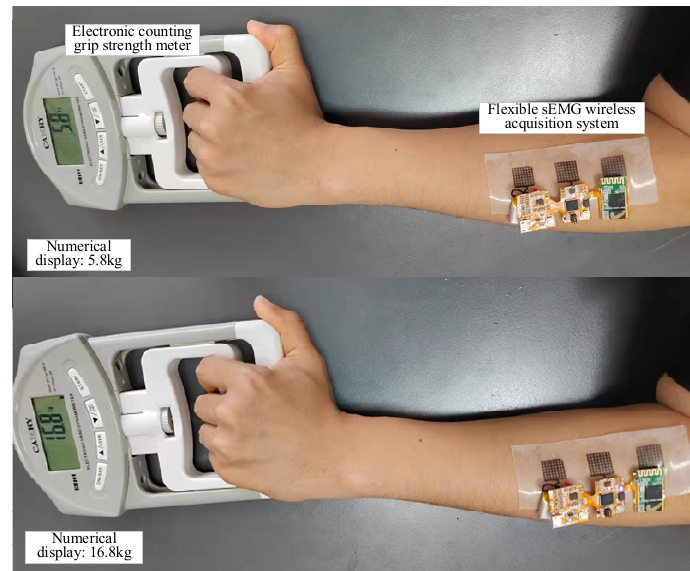
Figure 9. sEMG signals collected under different grip strength.